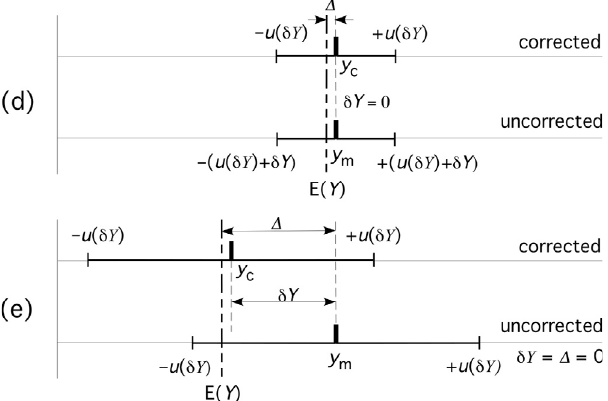
Fig. 2. Correction/no-correction process and outcomes: case when δY = 0. Symbols as in Figure